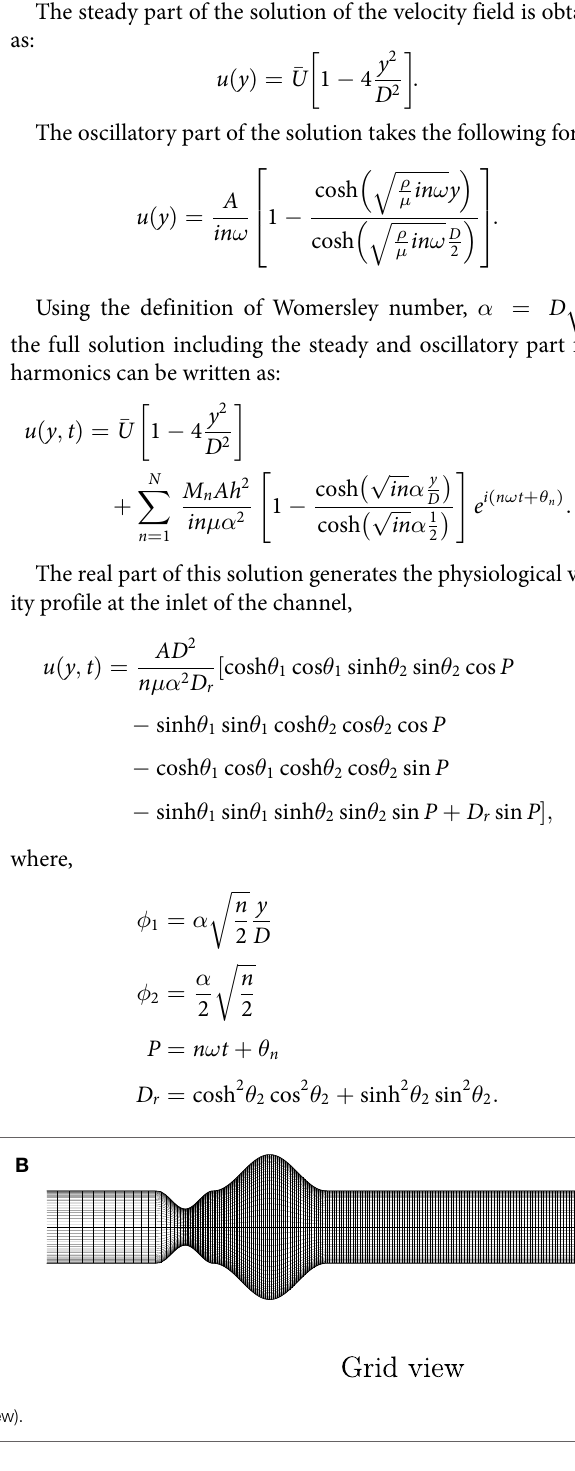
Frontiers in Mechanical Engineering |